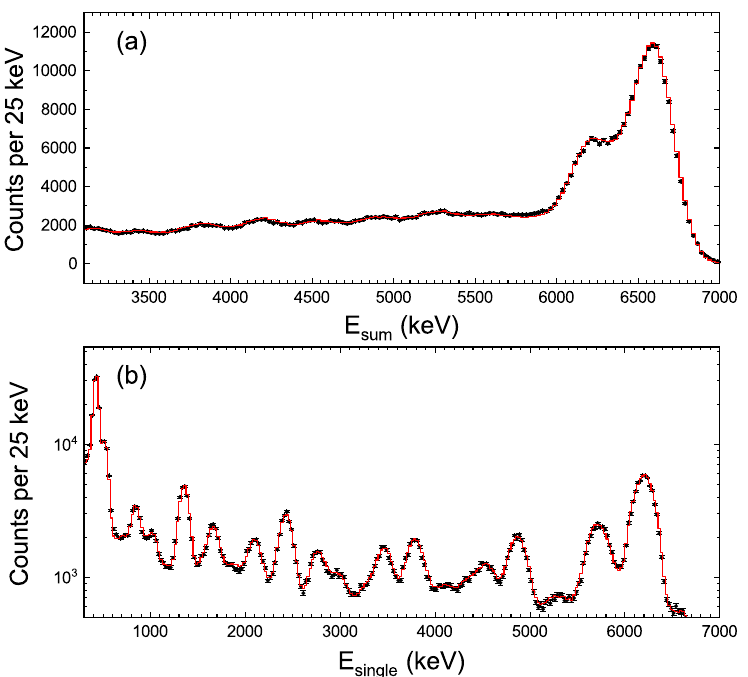
Figure 2: γ -ray spectra of the 304 keV 25 Mg(p , γ ) 26 Al resonance (black-filled circle). (a) Sum spectrum, the red line represents the GEANT4 simulation normalized to the experimental data. In the simulation the primary γ -ray branching ratios were extracted from the single spectrum. (b) Single spectrum, the red line represents the fitting